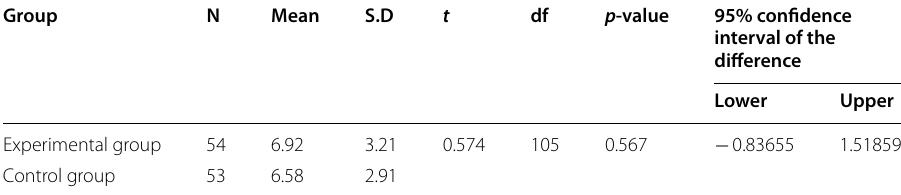
interval of the difference Lower Upper